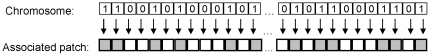
Chromosome structure.A chromosome is a binary string with a length of N to represent the presence or absence of each of the N possible features. Each bit of this binary vector is related to a feature. If the value of a bit is 1, then it represents the presence of a particular patch in the learning procedure, and if the bit is 0, it shows this patch does not have any effect on learning process.